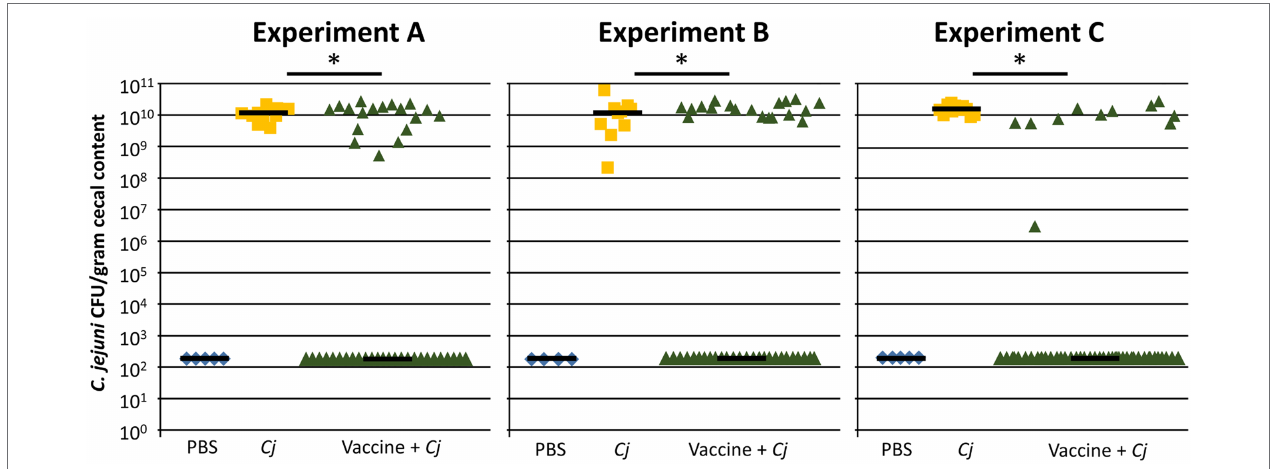
FIGURE 1 | The APEC O78-based C. jejuni vaccine significantly reduces C. jejuni colonization in broilers. Results from three independent E. coli -based vaccination and C. jejuni strain 81-176 challenge studies are shown. Birds in the negative control group (PBS, Experiment A, B, C; n = 5, 4, 5) were non-vaccinated and non- challenged; birds in the positive control group ( Cj , n = 10, 10, 10) were non-vaccinated but challenged with 1 × 10 6 CFU of C. jejuni wild type on day 28. Birds in the treatment groups (Vaccine + Cj , n = 44, 45, 46) were orally gavaged on days 7 and 21 with 1 × 10 8 CFU of the attenuated APEC O78-based C. jejuni vaccine and challenged with 1 × 10 6 CFU of C. jejuni wild type on day 28. Statistically significant differences (Fisher’s exact test, p < 0.001) are indicated by an asterisk. PBS, Phosphate-buffered saline; Cj , Campylobacter